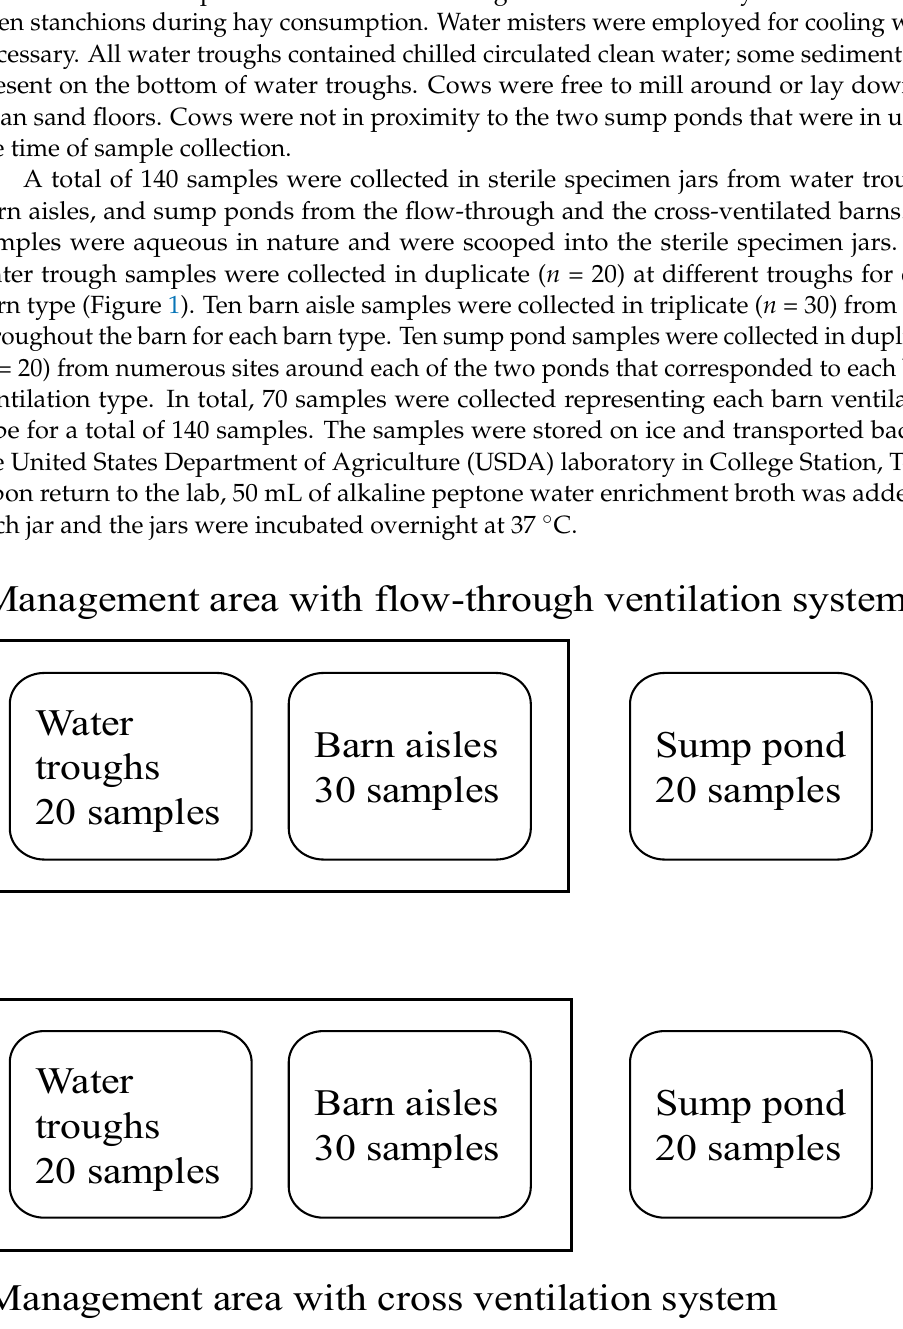
Figure 1. Location of samples on the farm.